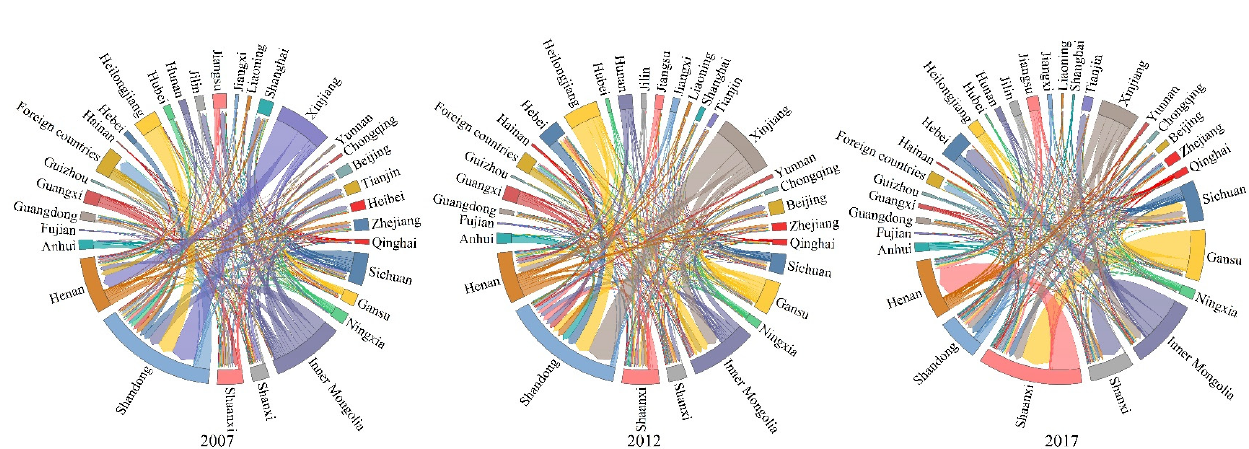
Figure 5. Virtual water flows of the nine provinces in the Yellow River basin, 2007–2017.